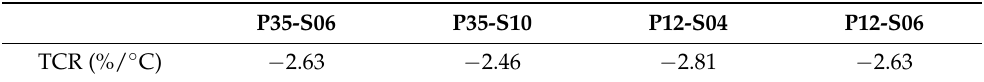
Figure 6. Cumulative probability curves of TCR extracted from the 11 devices for each of the four types of a-Si microbolometers. Table 2. Comparison of values at the midpoint (50%) of the cumulative curves plotted in Figure 6 of the four types of a-Si